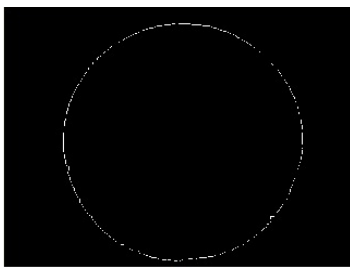
Figure 8. The boundary of the binary